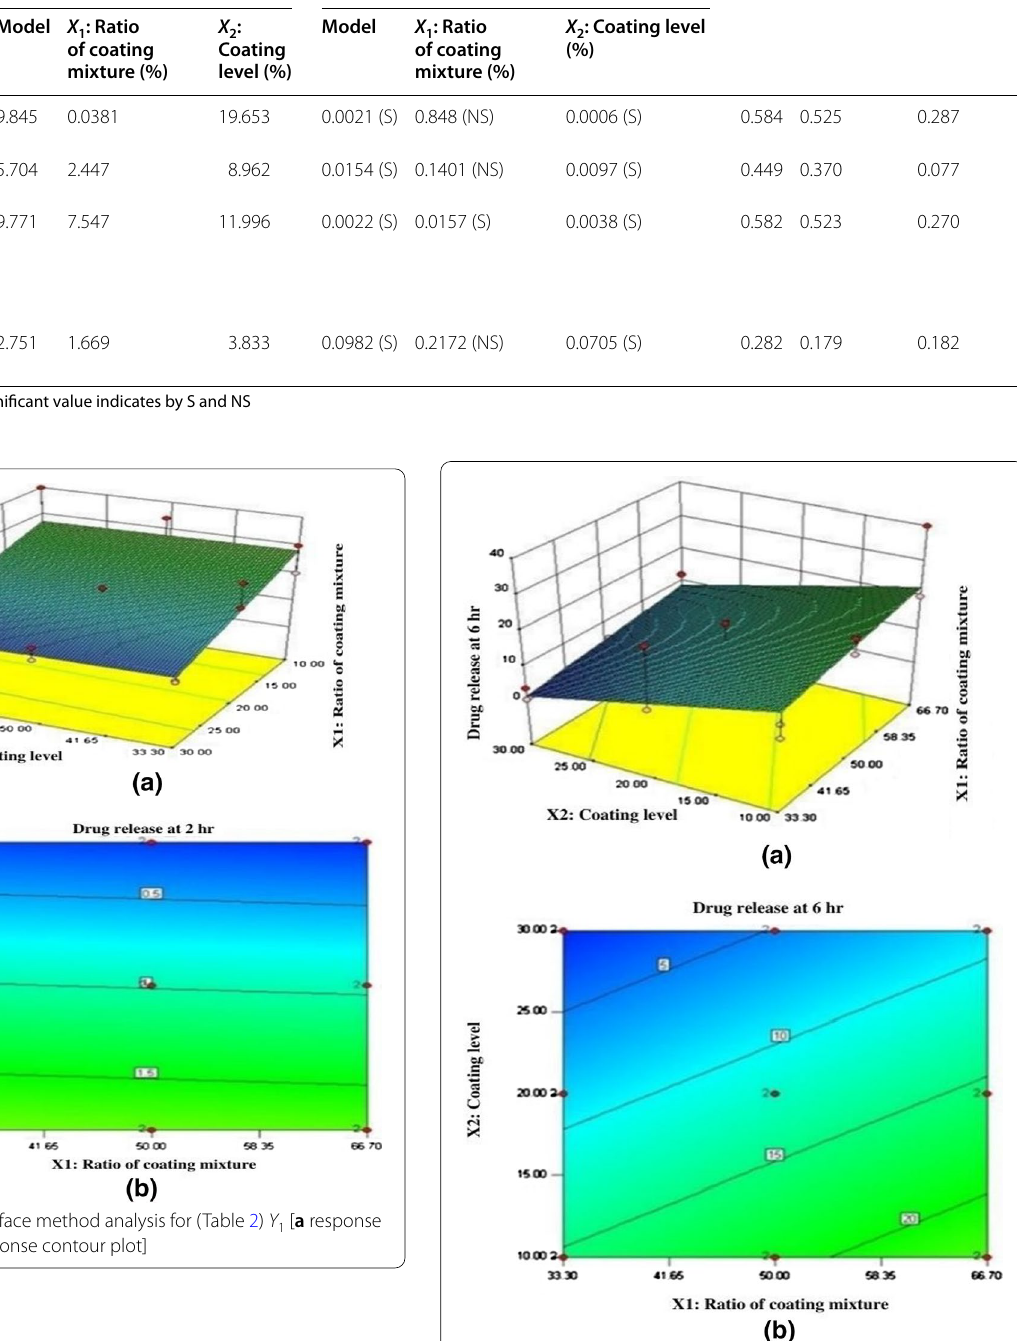
Table 5 Statistical summary of ANOVA for response surface design Response